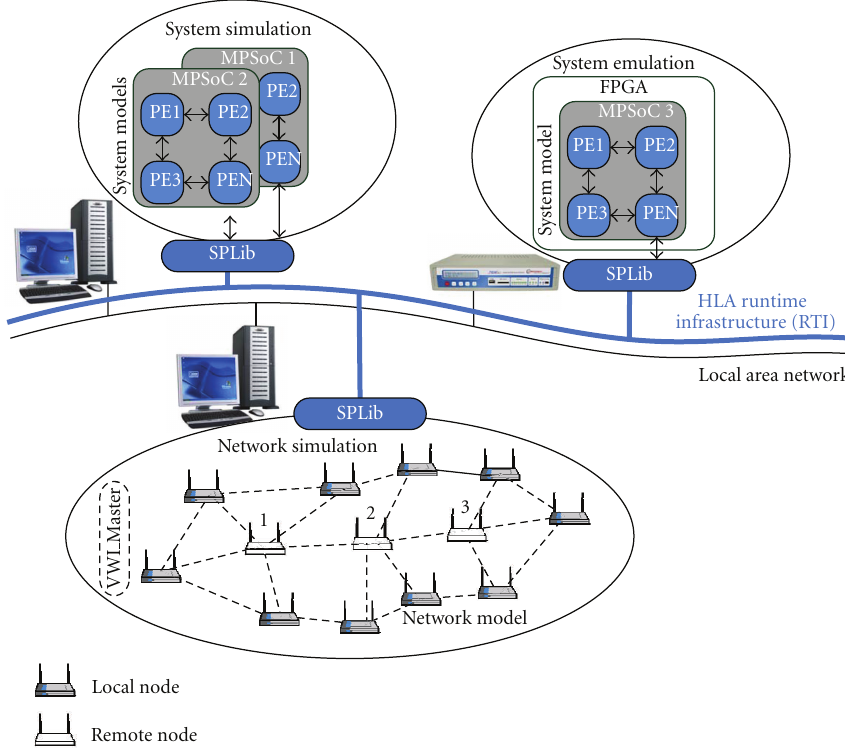
Figure 5: Simulation model and platform